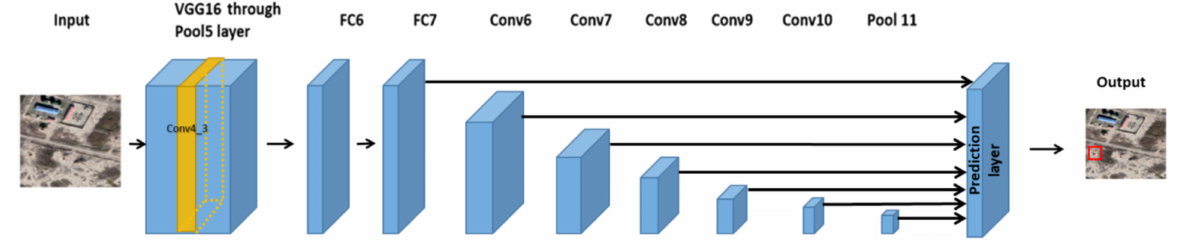
Figure 10. SSD framework.